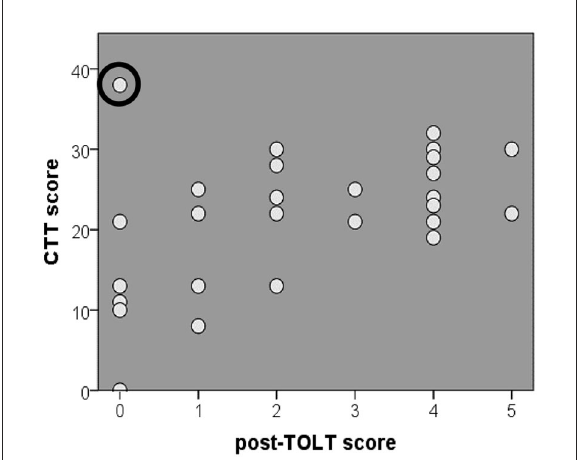
FIGURE6 CTT score for both intervention groups ± standard error, * p < 0.05. Shown are the CTT scores for both the MAVO and VWO intervention groups.